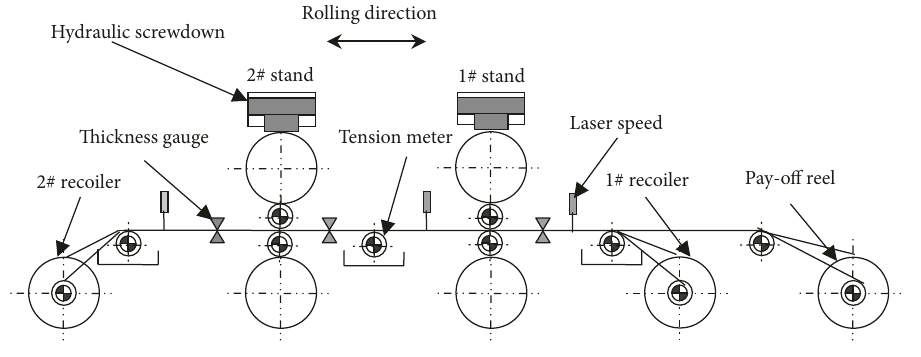
Figure 1: Typical two-stand reversible cold rolling